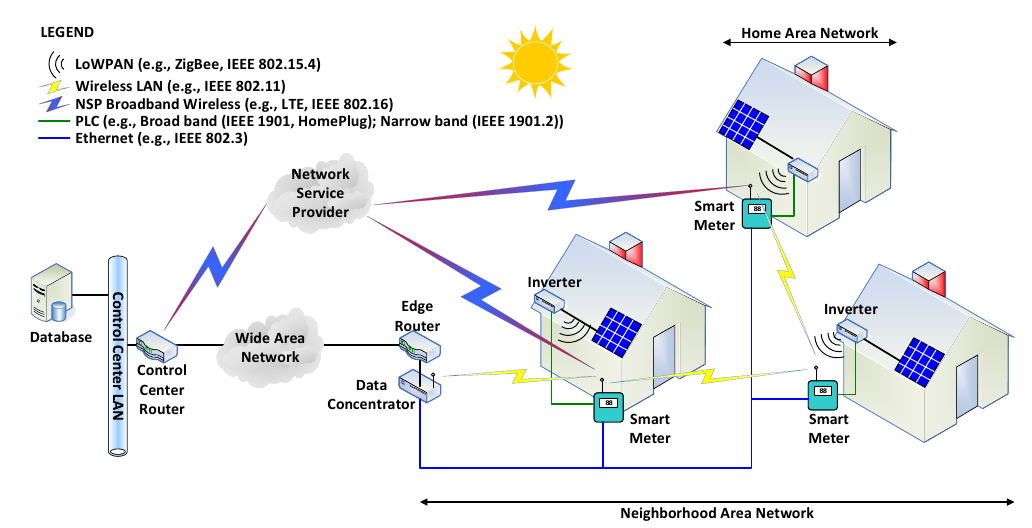
Figure 1. Envisioned smart grid communication